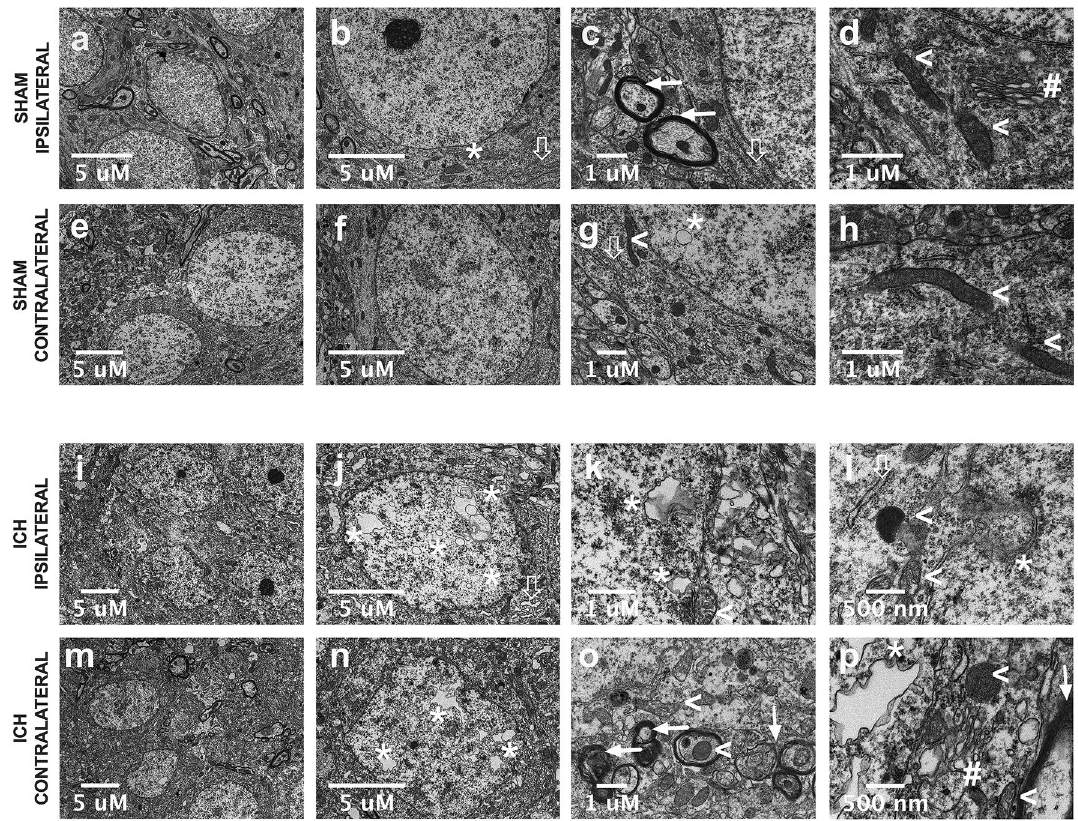
Figure 5. Representative transmission TEM images of hippocampal layer CA1 area in Experiment 4, in SHAM ( a – h ) and striatal ICH groups ( i – p ) at 24 h post-stroke. The asterisks identify the presence of the small intranuclear vacuoles that appear with relatively rare frequency in SHAMs. Solid arrows identify normal and intact myelinated axons, while non-solid arrows mark well-defined, narrow rough endoplasmic reticulum. Arrowhead symbols ( <) indicate intact healthy-looking mitochondria with well-defined and packed cristae, and the # symbol denotes Golgi apparatus, which looks structurally normal. In ICH rats, asterisks mark large intranuclear vacuoles that are spread throughout the nucleus, both contralaterally and ipsilaterally ( j – l , n , p ). Solid arrows indicate instances of axonal damage; signs of injury include thinning interrupted, unravelling, or “smudged” myelin accompanied by dilated periaxonal spaces ( o , p ). Mitochondria both within such axons and the cell soma are denoted by arrowhead symbols, and appeared to be extremely edematous, containing disorganized and interrupted cristae, with some in transitive stages of lysosomal degeneration ( l , o , p ). The hashtag symbol denotes a disrupted and edematous Golgi apparatus ( p ), and the non-solid arrow denotes rough endoplasmic reticulum that are swollen and distended ( j , l ). At low magnification, CA1 pyramidal cells in the ICH group have noticeably crenated nuclear and plasma membranes, with extremely dense cytoplasmic and nuclear contents, which we posit is the result of tissue compliance. In layer CA1, cells in the SHAM group have a characteristic ovoid shape with taught, intact membranes. Figure was made using GraphPad Prism version 8.4.3 for macOS, GraphPad Software, San Diego, California USA, www.graph